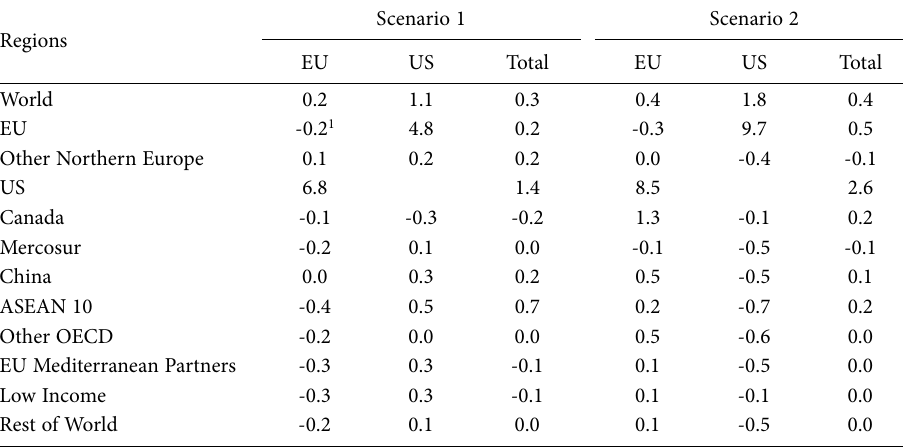
Table 2. Change in aggregate exports by region [%